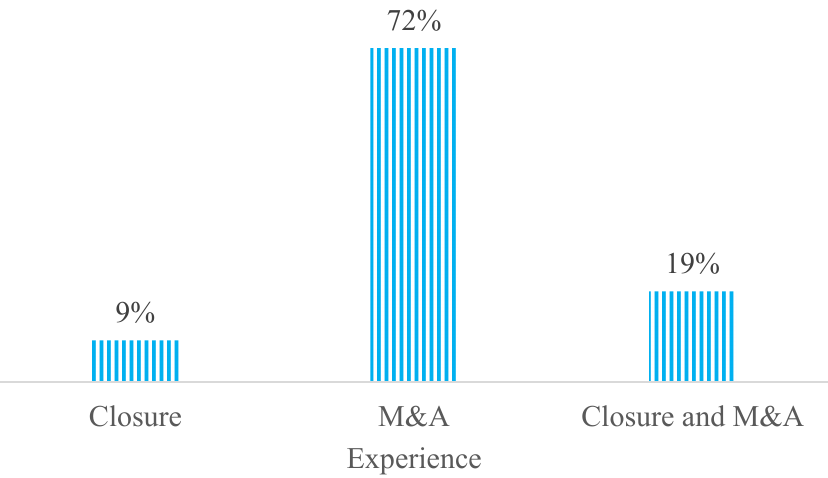
Figure 2. The share of types of experience among start-ups that underwent M&A.